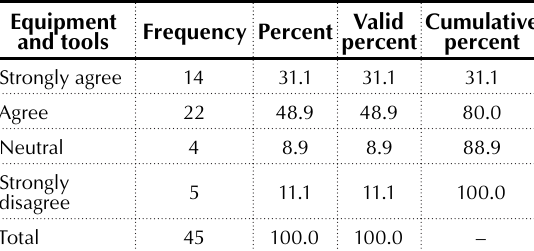
Table 2. Responses on equipment and tools